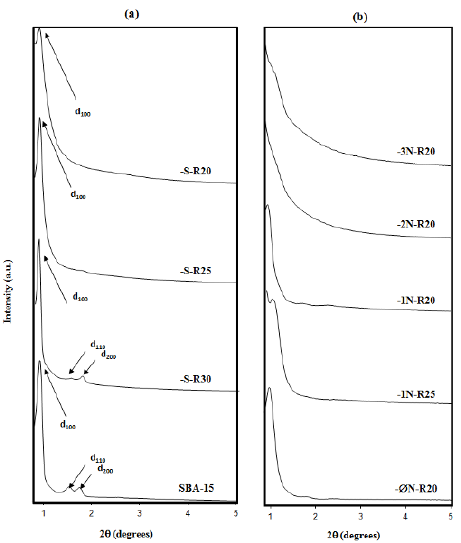
Figure 1. Powder X-ray diffraction patterns of: (a) the surfactant extracted SBA-15, surfactant extracted SBA-15 func- tionalized with 3-mercaptopropylmethyldimethoxysilane (samples -S-R30, -S-R25 and -S-20) and (b) the surfactant extracted SBA-15 functionalized with N-[3-(trimethoxysilyl)propyl]aniline (sample -ØN- R20), with aminopropyltrimethoxysilane (samples -1N-R25 and -1N-R20), with [amino-ethylamino]- propyltrimethoxysilane (sample -2N-R20) and with [(2-aminoethylamino)ethylamino]propyltrimethoxysilane (sample -3N-R20).